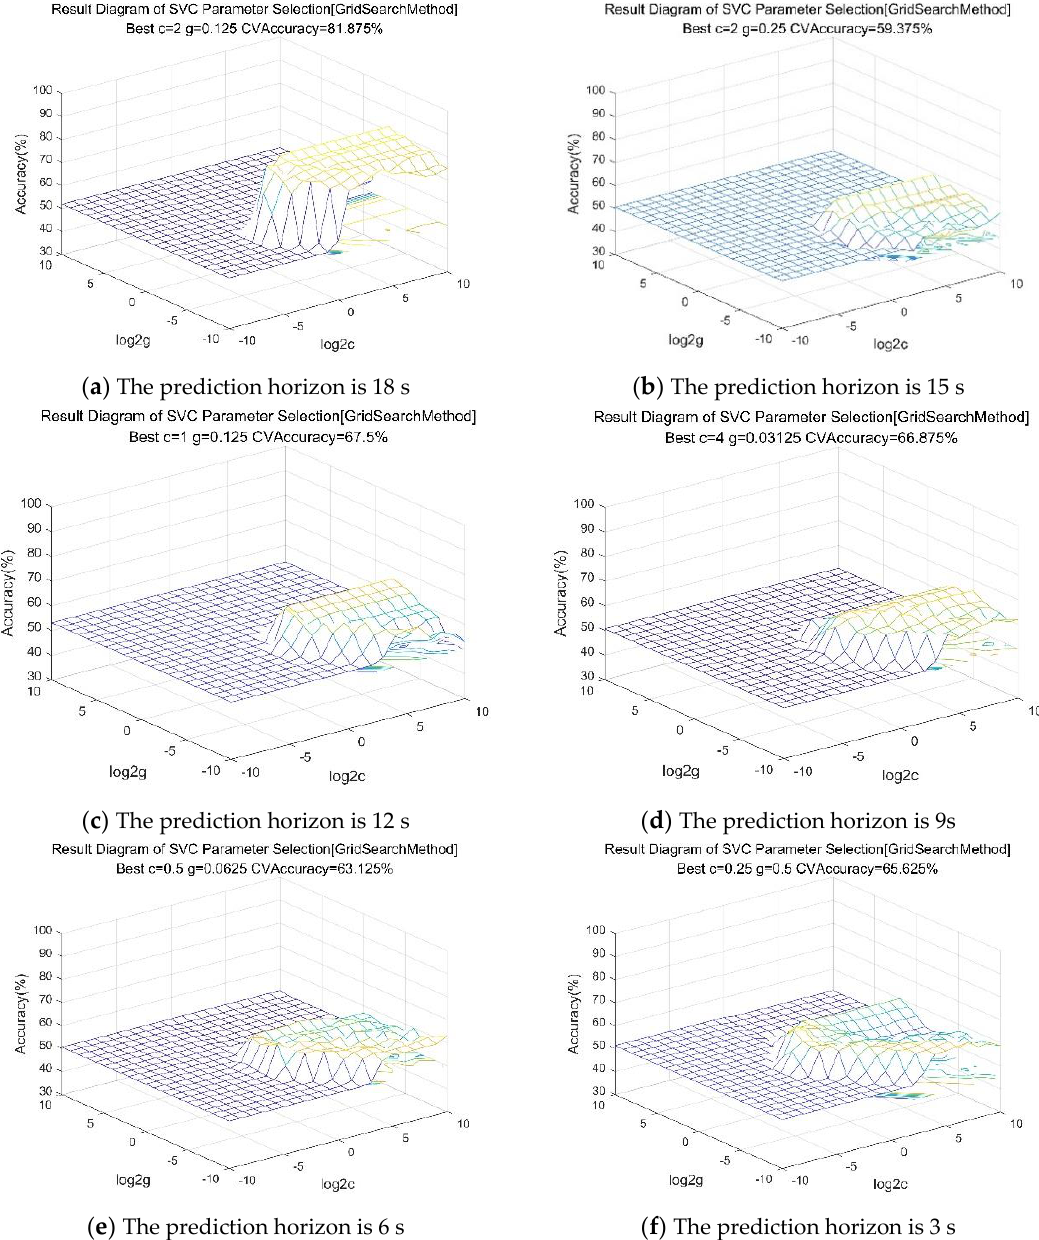
Figure 8. Parameter optimization results of I-SVM.